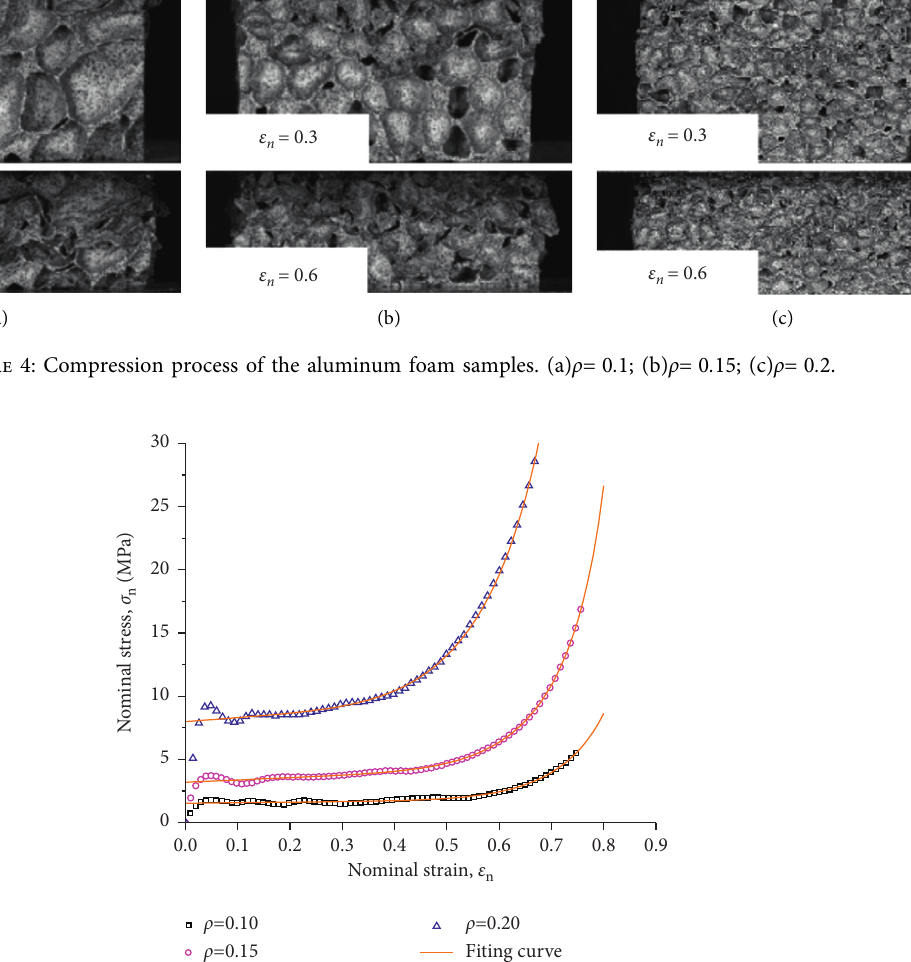
Table 3: Parameters σ